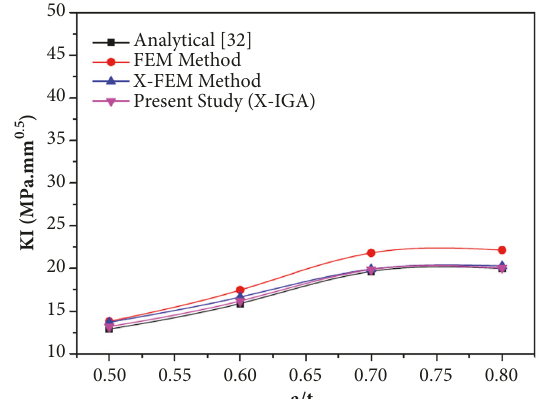
Figure 5: Variation of the Stress Intensity Factors (KI) with applied pressure for a half-tube case.